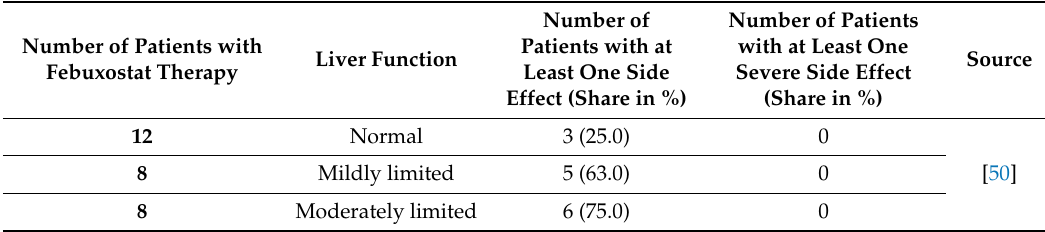
Table 1. Adverse events in patients depending on liver function (number of patients examined per group (column 1); liver function of patient group (column 2); patients with at least one side effect (column 3); patients with at least one severe side effect (column 4); publications reviewed (column 5); differentiation between side effect and severe side effect in accordance with the publications, no standard definition).